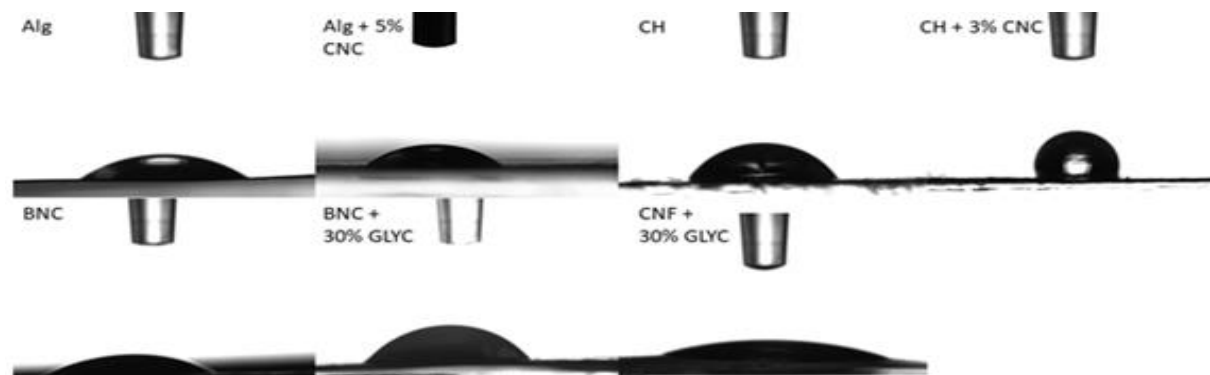
Figure 2. Visualization of the water contact angle for the selected films are shown in Table 1 (ALG—alginate; Alg + 5% CNC—alginate + 5% CNC; CH—chitosan; CH + 3% CNC—chitosan + 3% CNC; BNC—BNC; BNC + 30% GLYC—BNC + 30% glycerol; CNF + 30% GLYC—CNF + 30% glycerol).